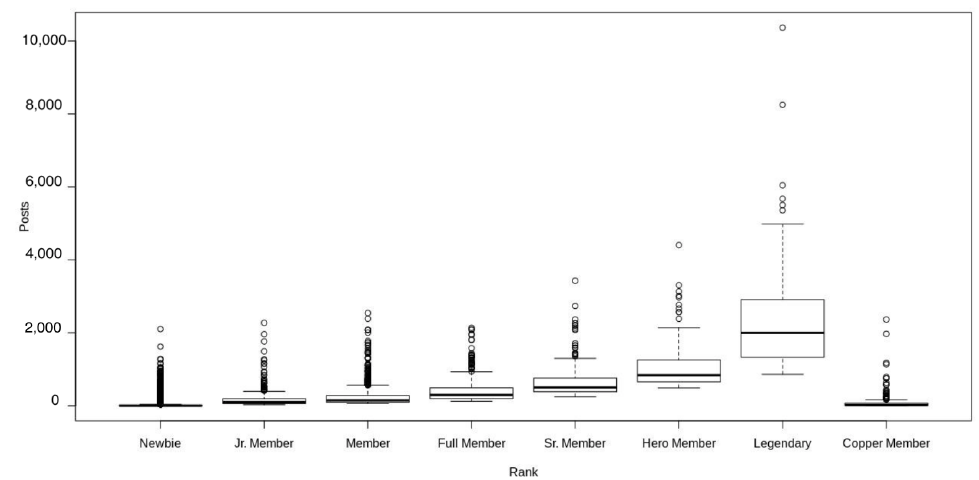
Figure 2. Number of posts per rank